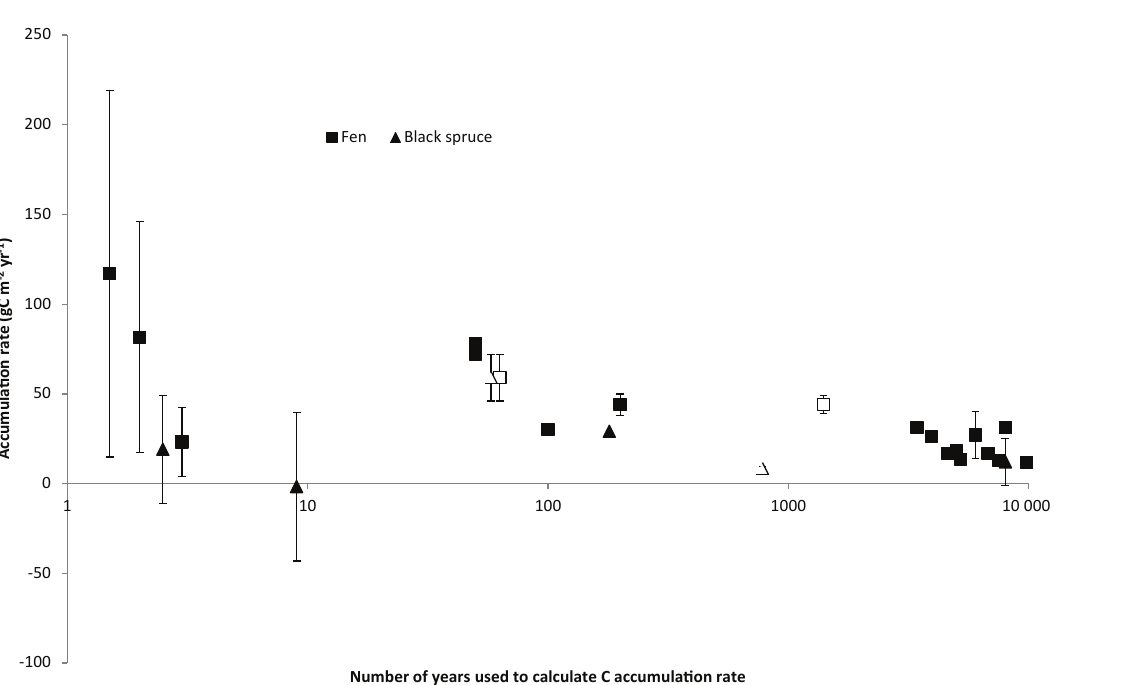
Figure 2. A comparison of organic soil C accumulation rates for fen and black spruce systems for this study (open symbols) and values found in the literature (solid symbols). Rates were calculated over many different time spans (annual to millennial). Errors (where available) are standard deviations. Literature values from Aurela et al. (2004), Aurela et al. (2009), Bauer et al. (2009), Camill et al. (2009), Dunn et al. (2007), Euskirchen et al. (2014), Harden et al. (2012), Mathijssen et al. (2014), Oksanen (2006), Turunen et al. (2002), Trumbore and Harden (1997), Yu et al. (2003) and Yu et al.